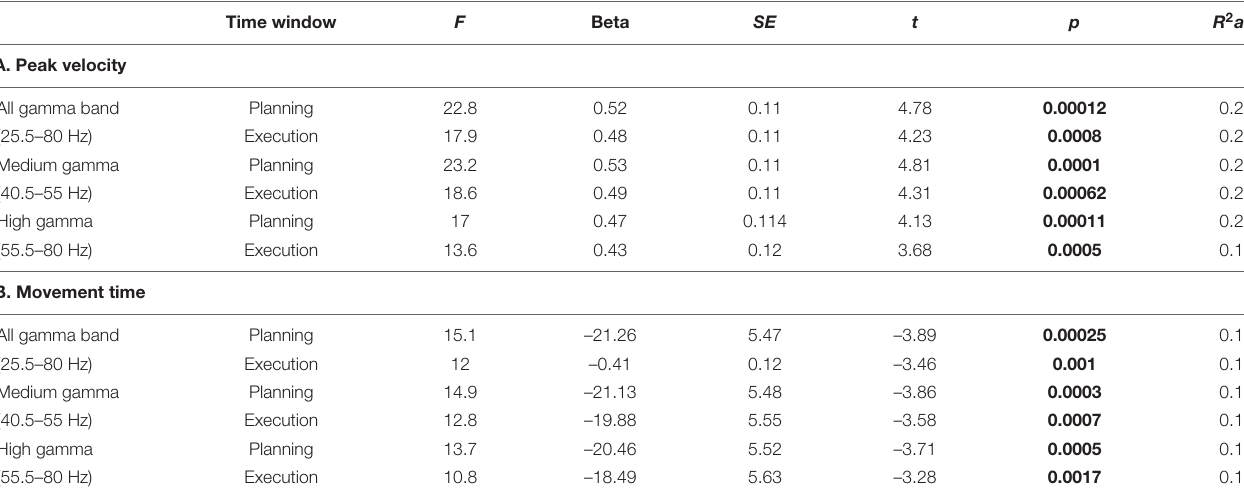
TABLE 2 | Linear regression models on the relationship between gamma amplitude and kinematic